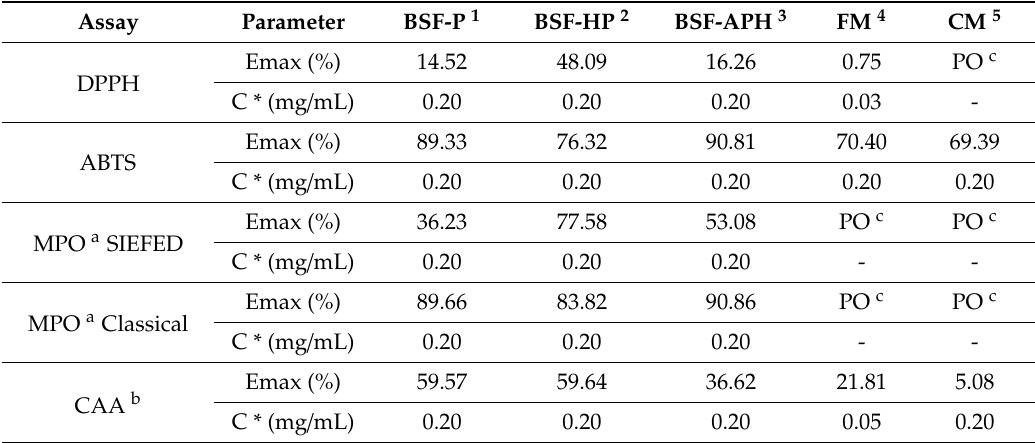
Table 5. Antioxidant activity E max (% inhibition) of samples obtained using di ff erent assays. ABTS: